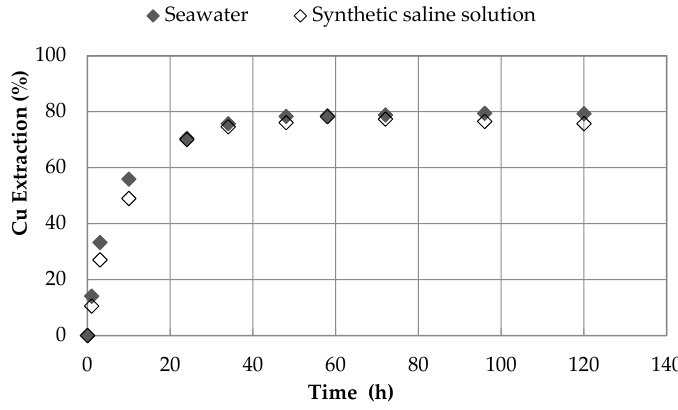
Figure 8. Comparison of copper extraction rates when leach solution was prepared in synthetic saline water and seawater. Experimental conditions: NaCl (35 g · L − 1 ), H 2 SO 4 (1 M), NaNO 3 (1 M), 5 days of leaching and 45 ◦